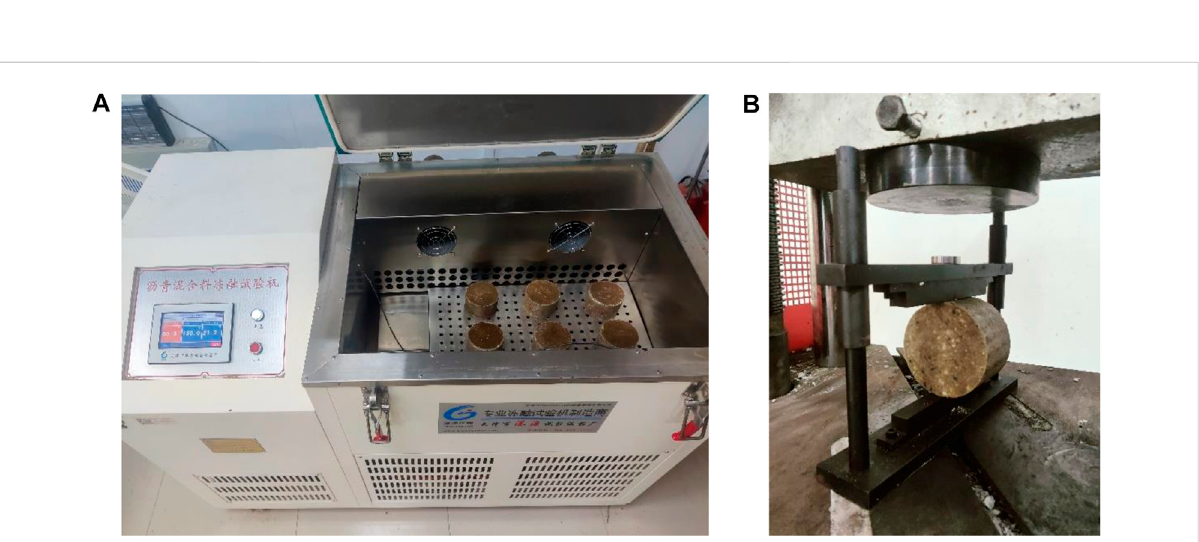
FIGURE 7 Freeze-thaw splitting test procedure. (A) Freeze-thaw cycle procedure; (B) Splitting test.